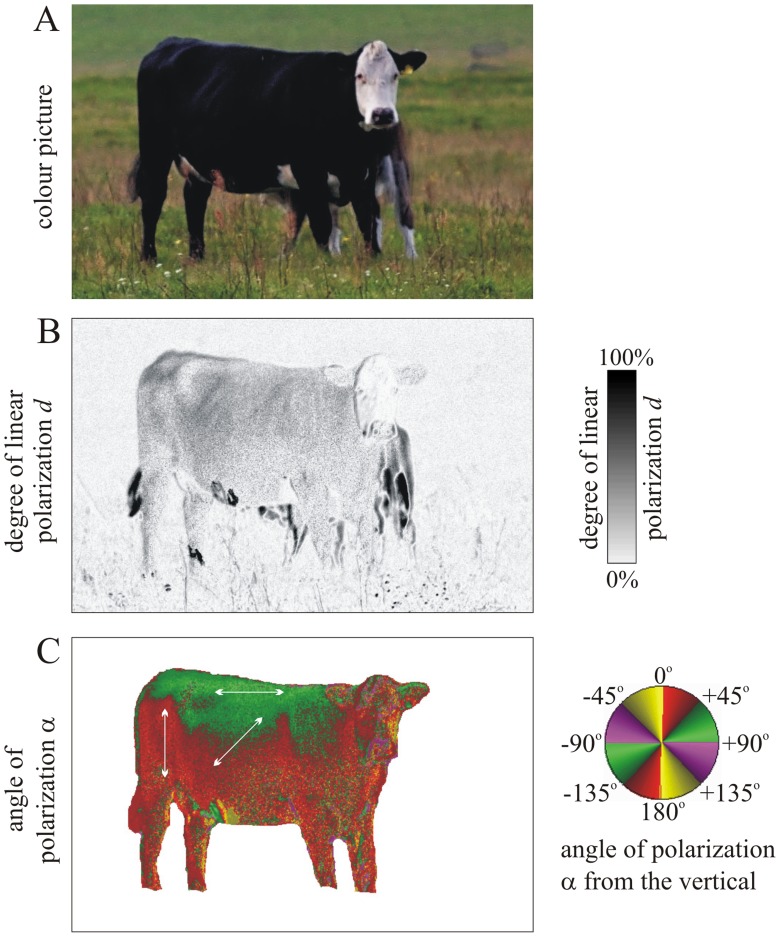
Colour picture and patterns of the degree of linear polarization d and angle of polarization α (clockwise from the vertical) of a living shady black cattle measured by imaging polarimetry in the blue (450 nm) part of the spectrum.The optical axis of the polarimeter was horizontal, and the measurement was performed under an overcast sky. In the α-pattern double-headed arrows show the angle of polarization of reflected light at some places of the cattle coat. The background of the animal is white for the sake of a better visualization. The body surfaces of the cow from which light is reflected in a vertical plane polarize horizontally, while those from which light is reflected in a horizontal/oblique plane polarize vertically/obliquely.